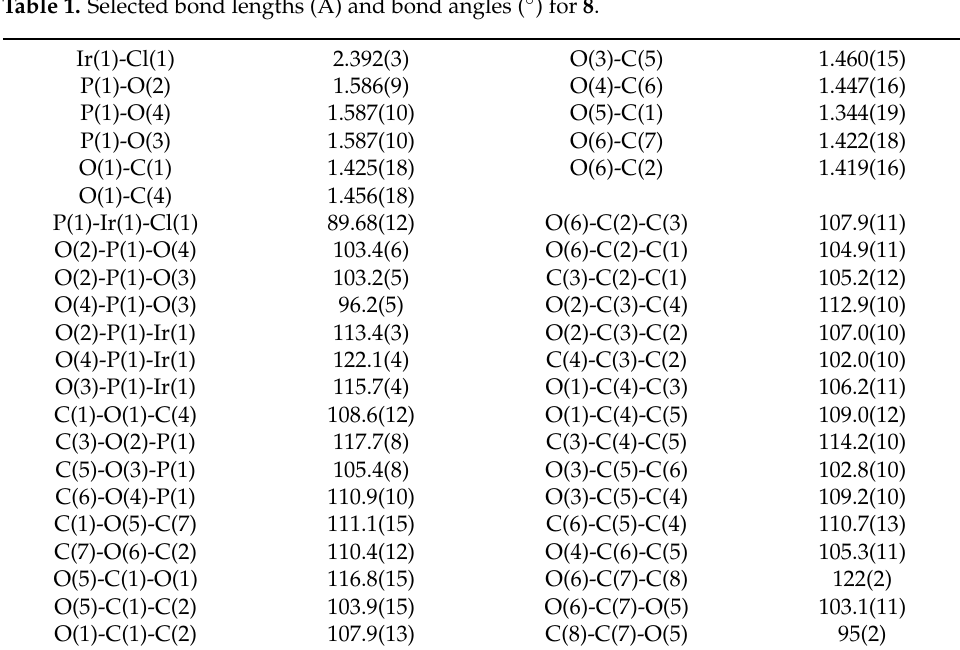
Table 1. Selected bond lengths (Å) and bond angles (°) for 8 .